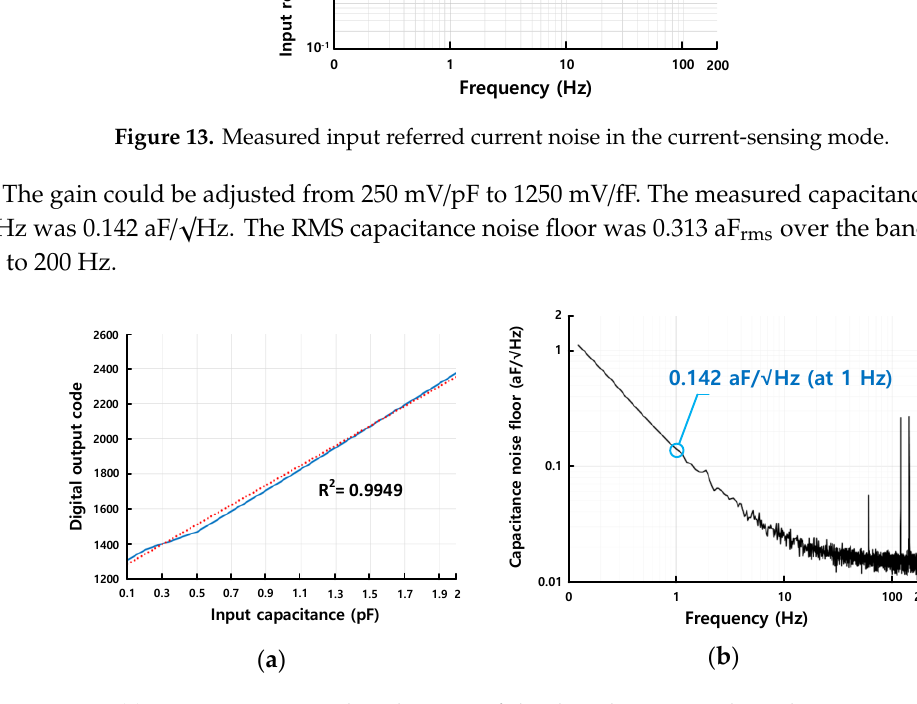
Figure 14. ( a ) Linearity expressed as the ratio of the digital output code to the input capacitance. ( b ) Capacitance noise floor.